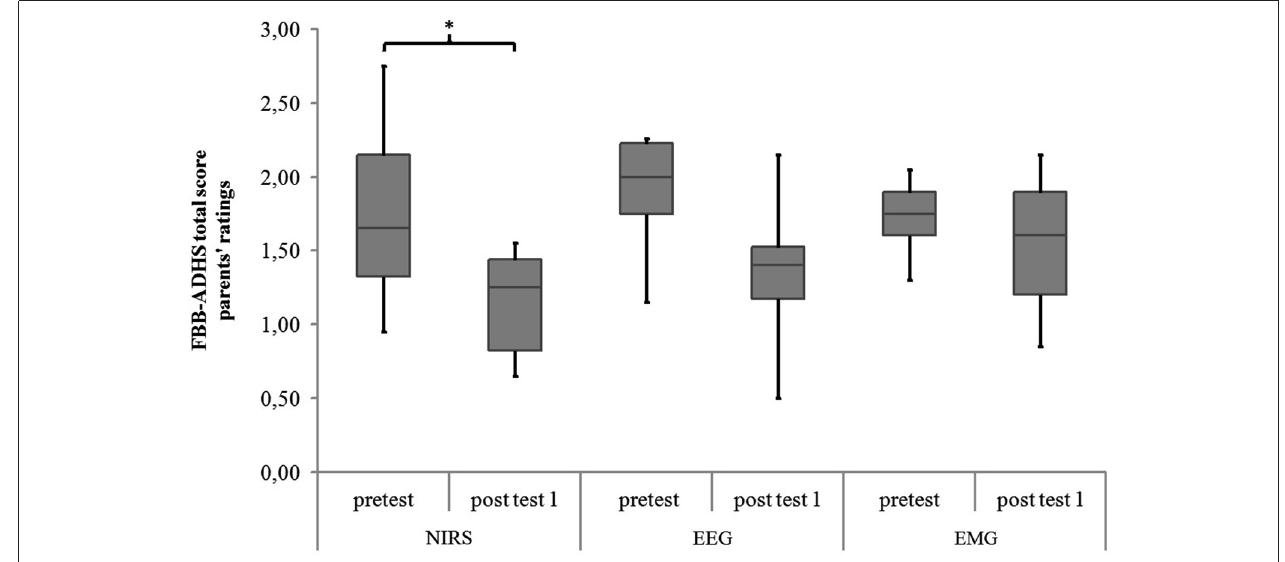
box = interquartile range, error bars = minimum respectively maximum, * =